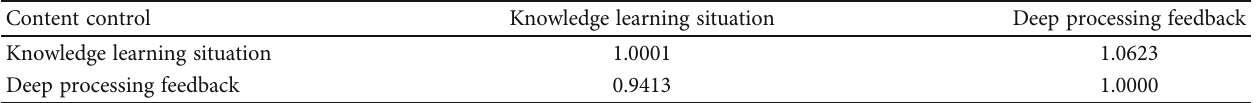
Table 2: Content after aggregation master the judgment matrix of next level indicators.